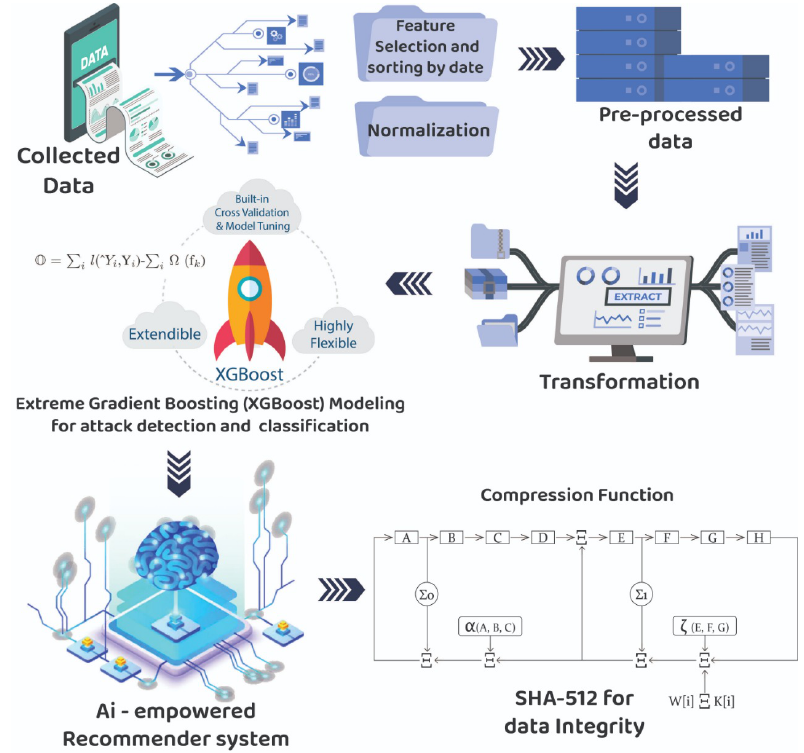
Figure 3. AI-ADP: The